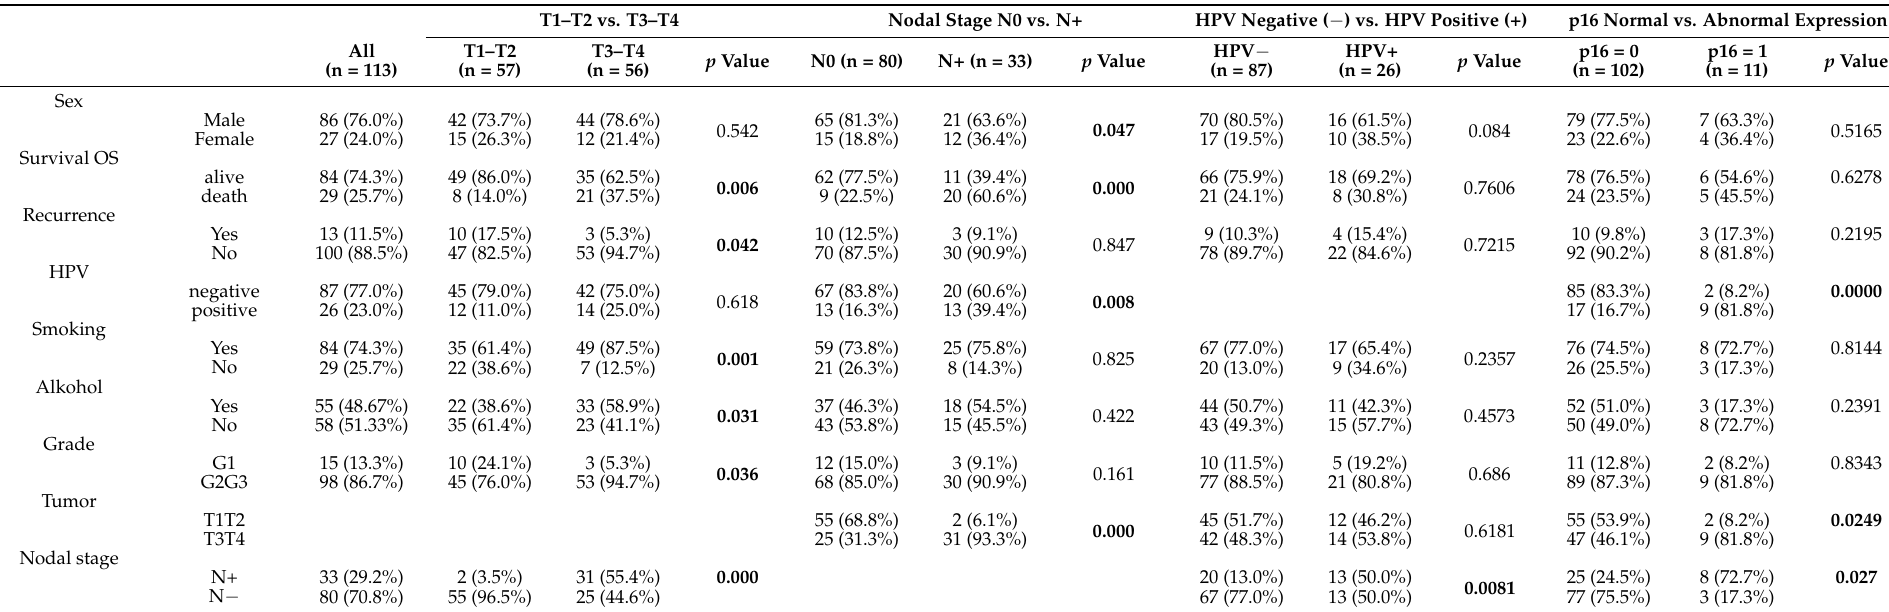
Table 2. Characteristics of the patient group and the impact of the clinical stage of the disease, the presence of metastases, HPV infection and p16 protein expression on selected variables. ( p < 0.05 was bolded; abbreviations: OS—overall survival; HPV—human papilloma